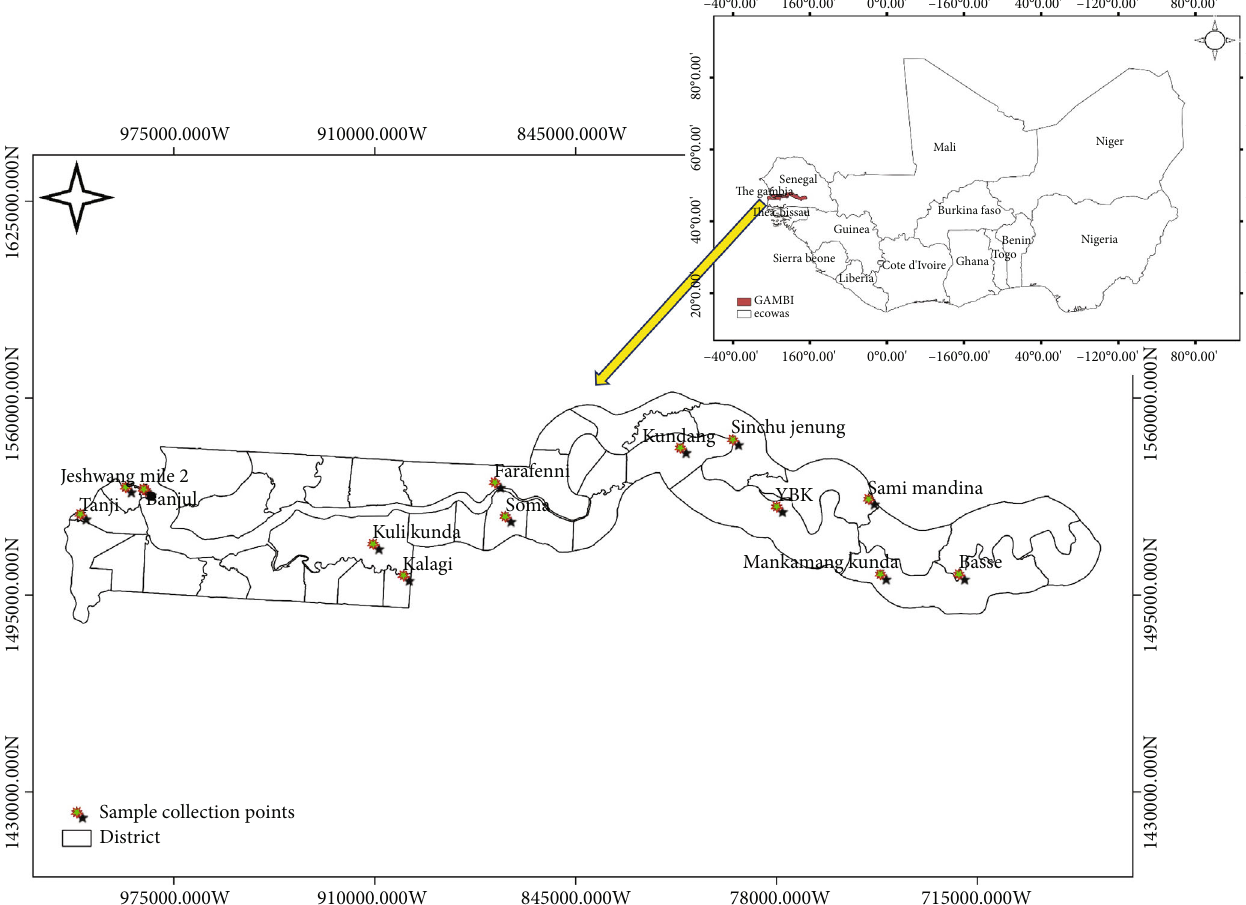
Figure 1: Map of The Gambia showing its position in West Africa and the location of the present study. The fi gure was generated and modi fi ed using ArcGIS